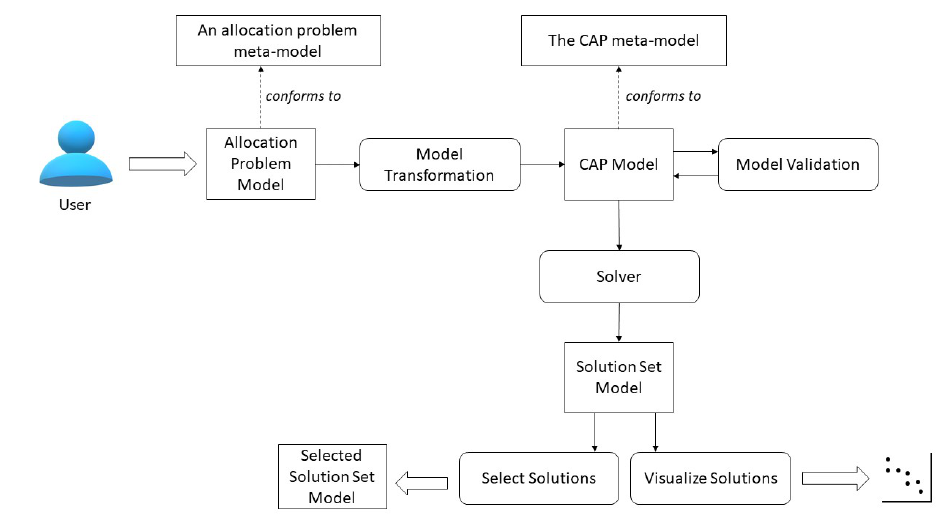
Figure 3. Overview of the proposed framework for solving